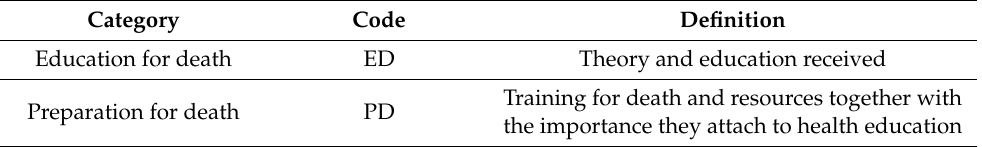
Table 2. Description of the analysis